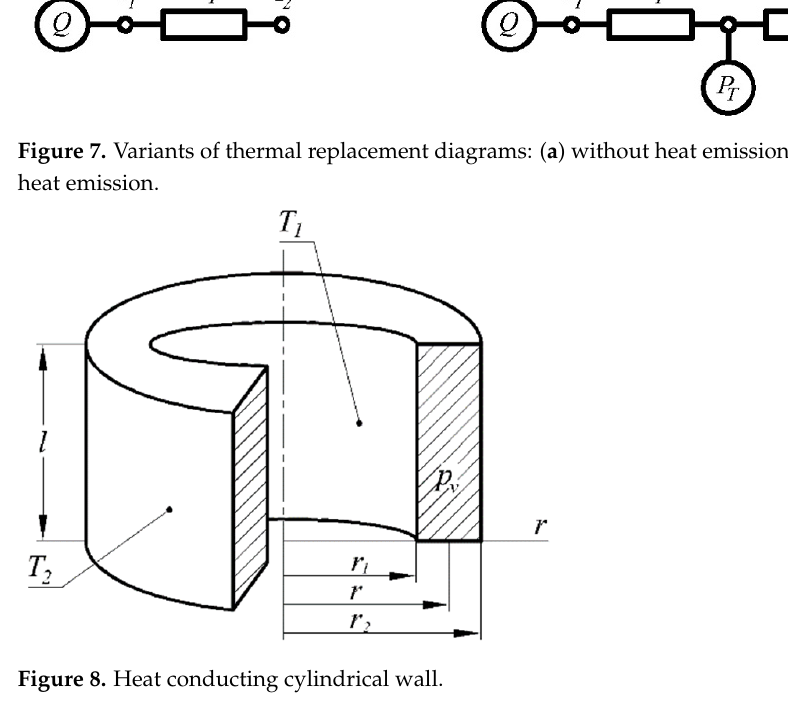
Figure 8. Heat conducting cylindrical wall.